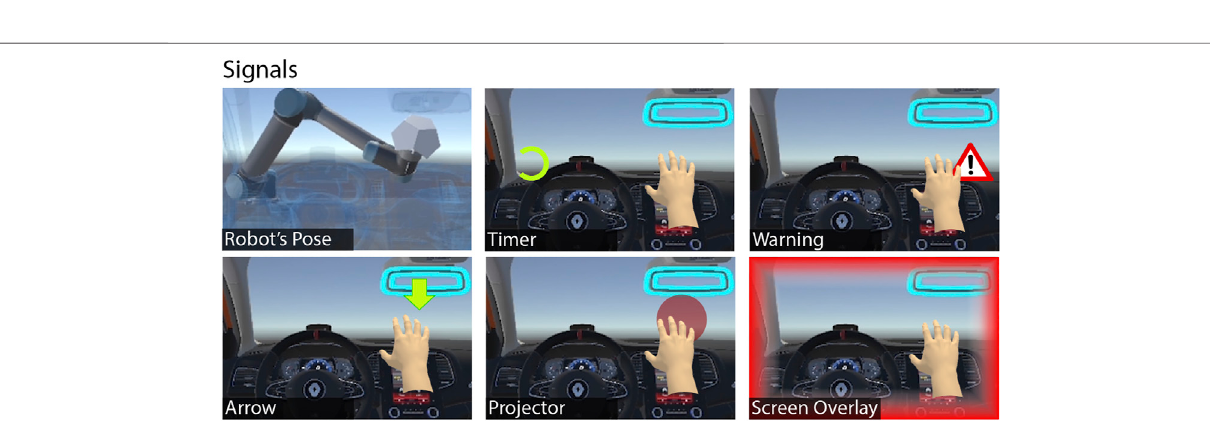
Frontiers in Virtual Reality |